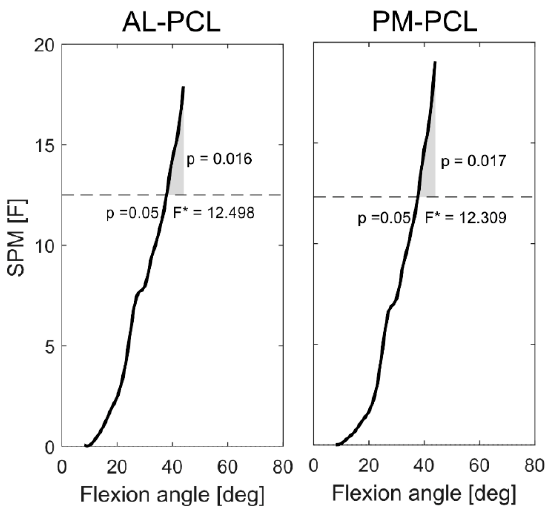
Figure 5. SPM plots show significantly different ligament elongation patterns between level walking and stair descent for flexion angles greater than approximately 40° (SPM tests were performed only over the swing phases of the activities, and within the range of knee flexion covered by all included trials).